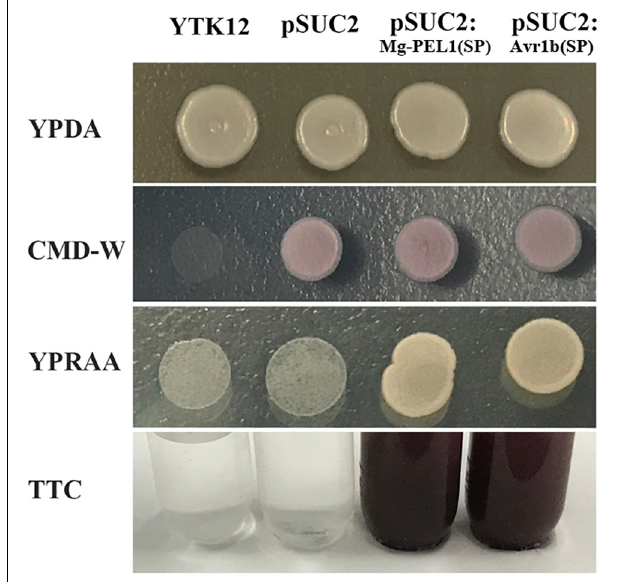
FIGURE 3 | Secretion function analysis of Mg-PEL1 signal peptide. The predicted signal peptide of Mg-PEL1 was cloned into the yeast vector pSUC2 to generate pSUC2:Mg-PEL1(SP)-invertase construct, and pSUC2:Avr1b (SP)-Invertase was used as a positive control. The YTK12 strain and YTK12 carrying the empty pSUC2 vector were used as negative controls. YTK12 can grow on YPDA plates. CMD-W media was used to ensure the expression of pSUC2-derived plasmids. Yeast transformants were grown on the YPRAA media to detect invertase secretion. Meanwhile, enzymic activity of invertase was further confirmed by the reduction of the dye 2, 3, 5-triphenyltetrazolium chloride (TTC) to the insoluble red-colored triphenylformazan. The experiment was repeated three times independently.